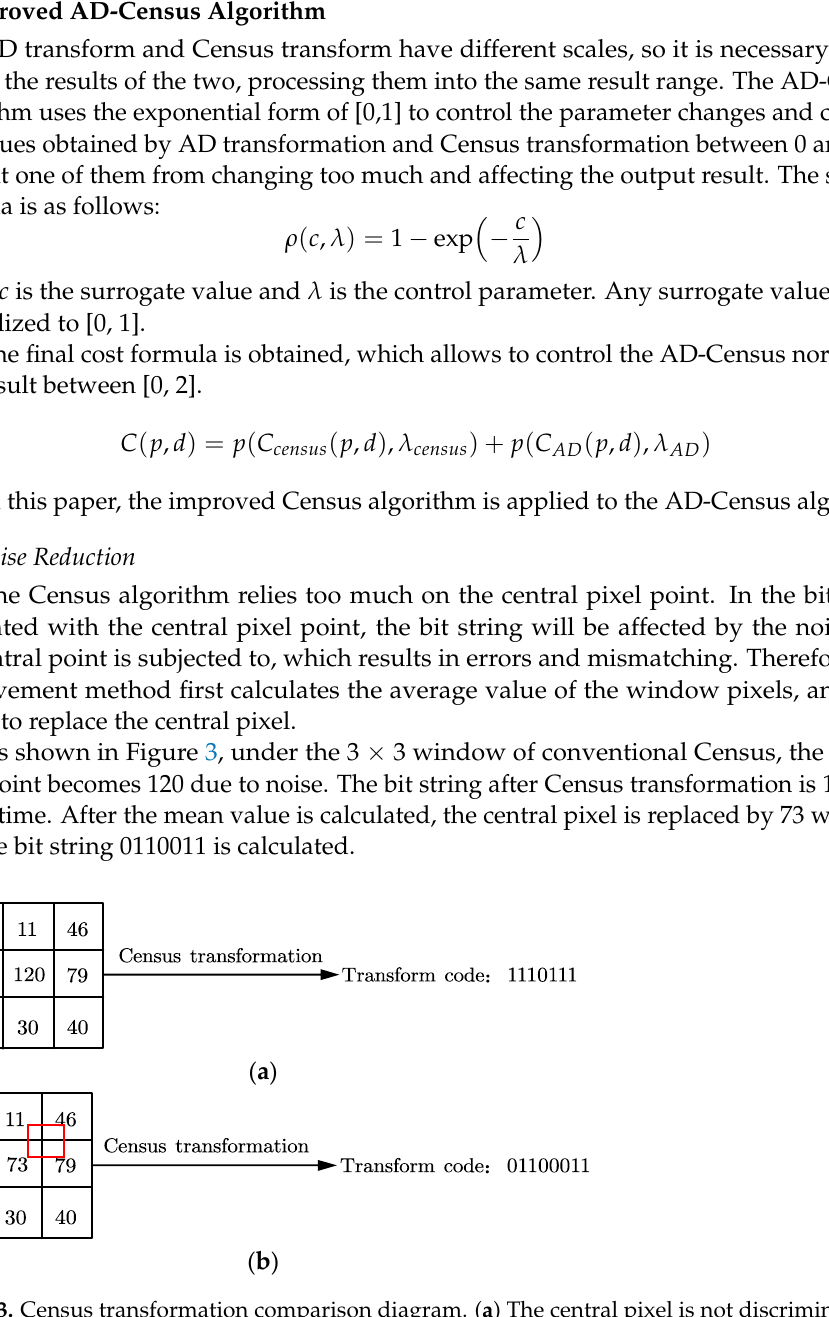
Figure 3. Census transformation comparison diagram. ( a ) The central pixel is not discriminated by interference. ( b ) The central pixel is interfered with to discriminate.